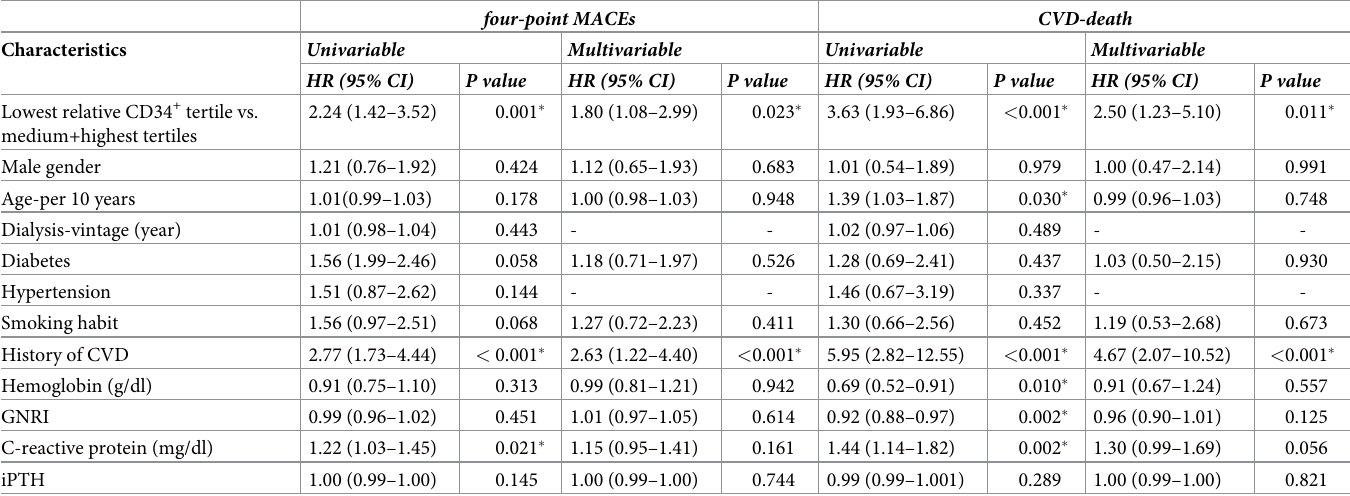
Table 3. The hazard ratio of associated factors for cardiovascular